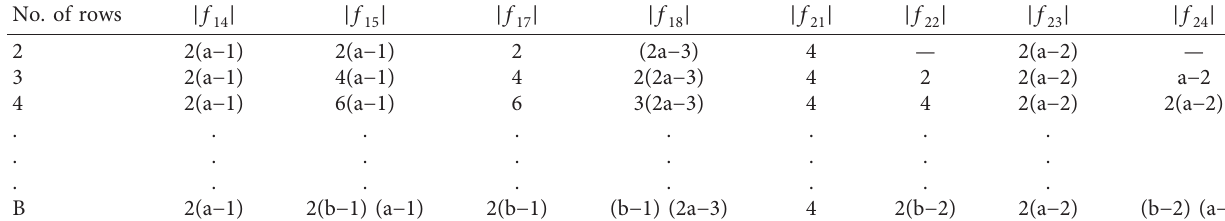
with given number of rows. 24